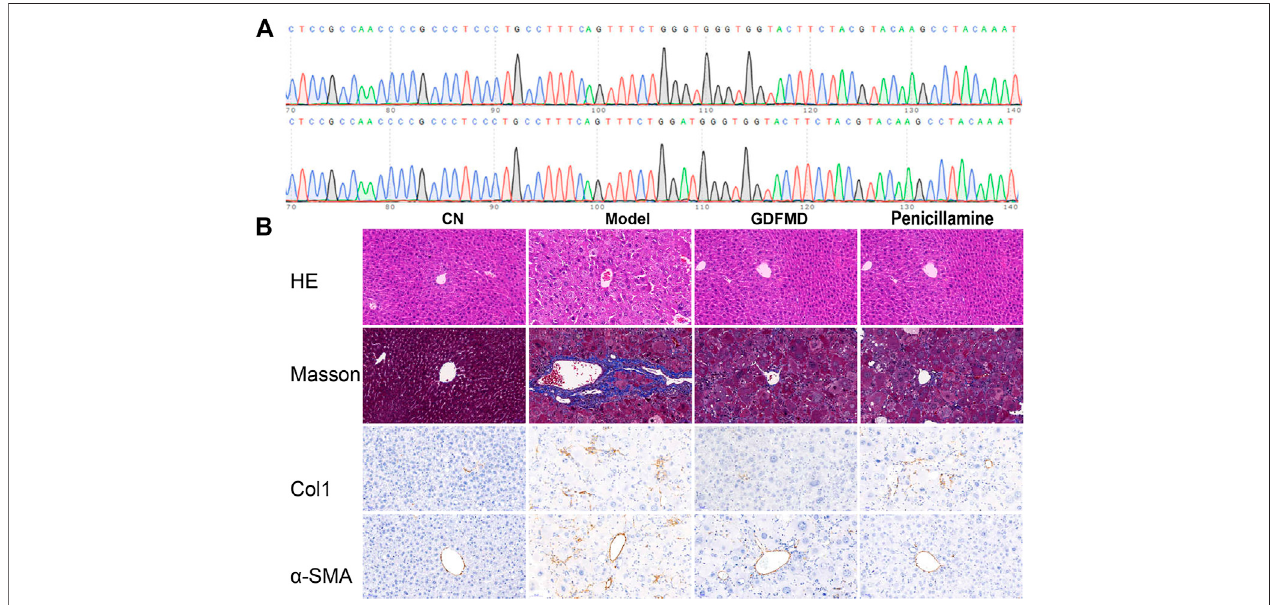
FIGURE 1 | GDFMDreversedDEGswithModel (A) TheVenndiagramofGDFMD-revisedgenewithWD.down-DEGs(Modelvs.CNandGDFMDvs.Model,down-and up-regulated, respectively) and up-DEGs (Model vs. CN and GDFMD vs. Model, up- and down-regulated, respectively) (B) Heatmap of down-DEGs and up-DEGS.